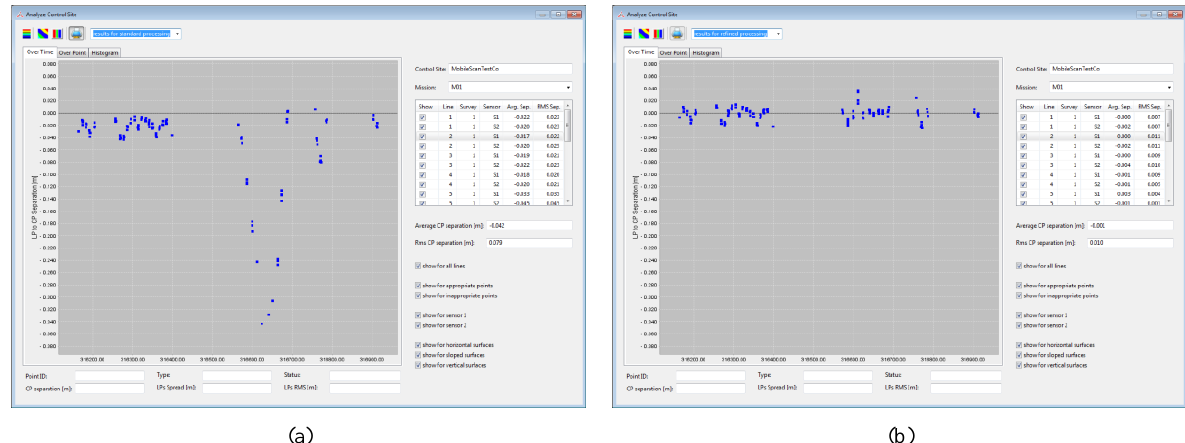
Figure 5. Separation between lidar data and control points over time before (a) and after (b) the post-mission QA procedure.